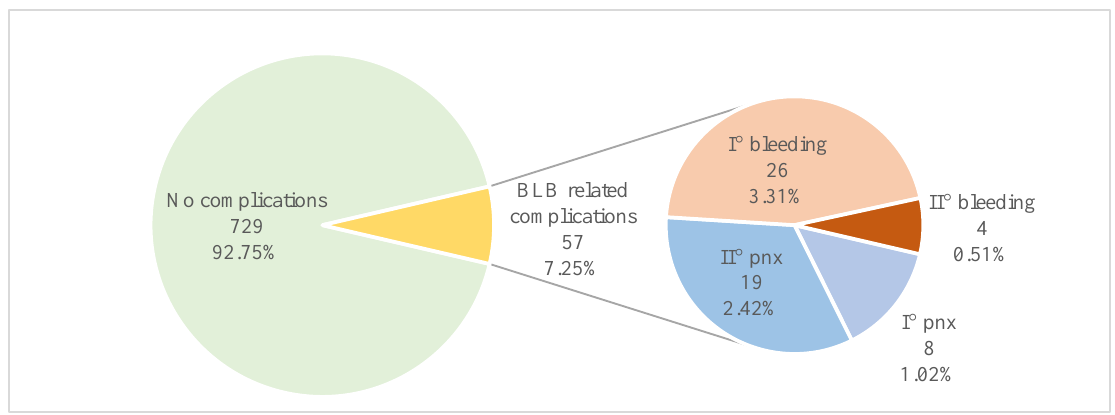
Figure 2. Complications of the bronchoscopic lung biopsy procedure. pnx — pneumothorax. Table 2. Patients’ age and complications